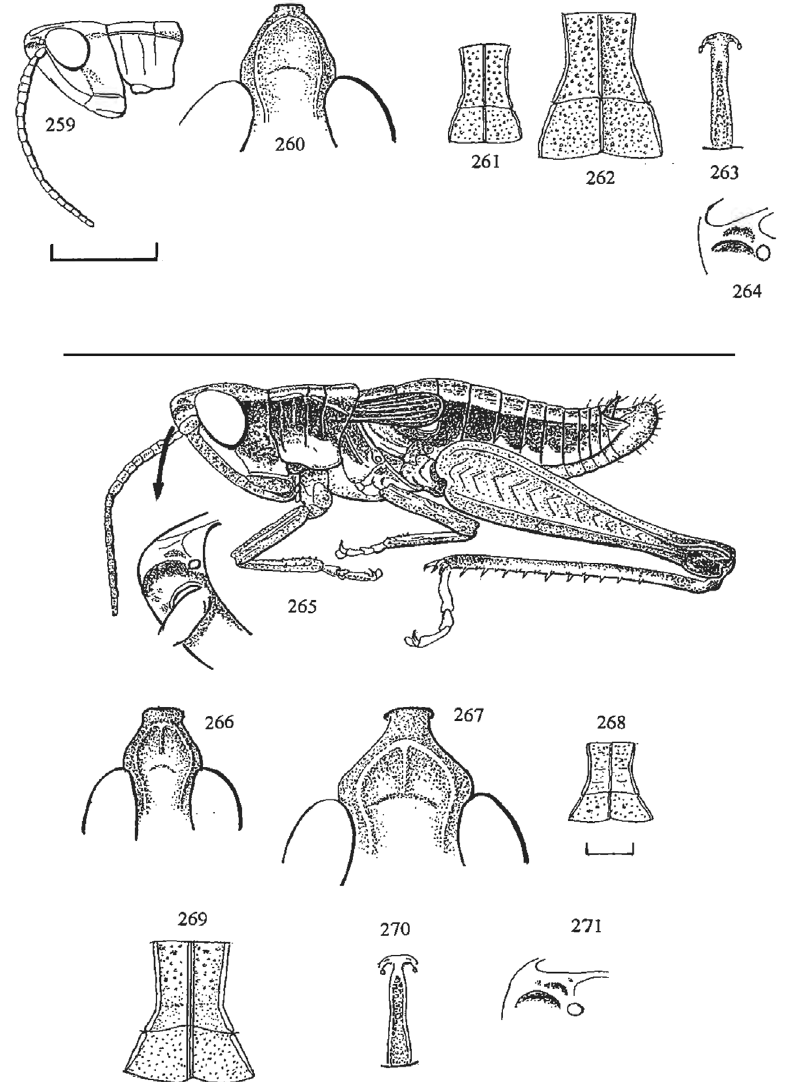
Figs 259–271. Tribe Gymnobothrini. Gynmobothrus levipes. Figs 259–264. Gynmobothrus levipes levipes male: 259. Lateral aspect head and pronotum; 260. Dorsal view apex of head; 261, 262. Male, female pronotal discs; 263. Frontal ridge; 264 . Temporal foveolus. Figs 265–271 . Gymnobothrus levipes abbreviatus male: 265. Entire insect ( Gymnobothroides keniensis Johnston 1937 , n. syn. ); inset below an enlargement of apex of head showing temporal foveolus; 266, 267. Male, female, dorsal view vertices; 268, 269. Male, female pronotal discs; 270. Frontal ridge; 271. Temporal foveolus. All scale lines represent l mm: that below Fig. 259 applies to Figs 260, 264, 266, 267, 271; that below Fig. 268 applies to Figs 259, 261–263, 265,